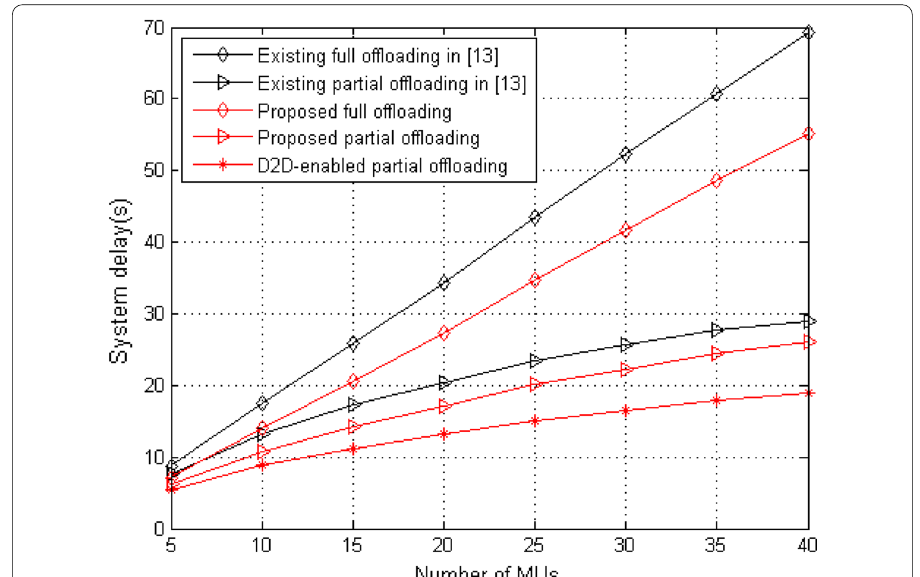
Fig. 5 The system delay with the number of